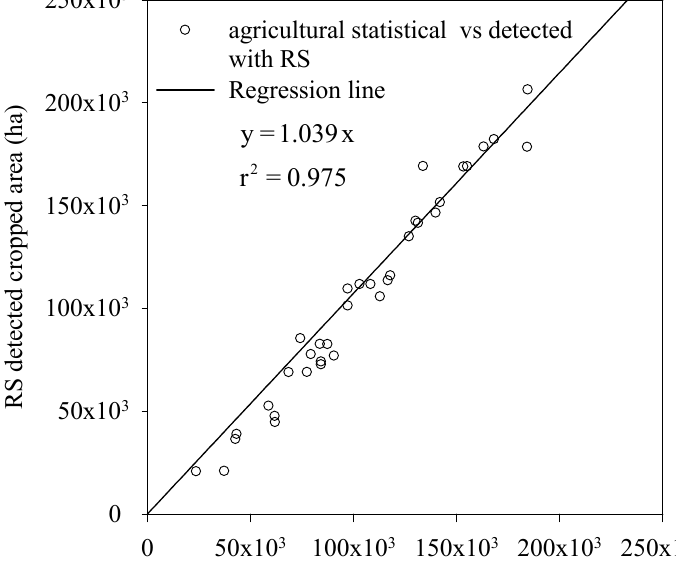
Figure 6. Validation of cropped area using agricultural statistical data.